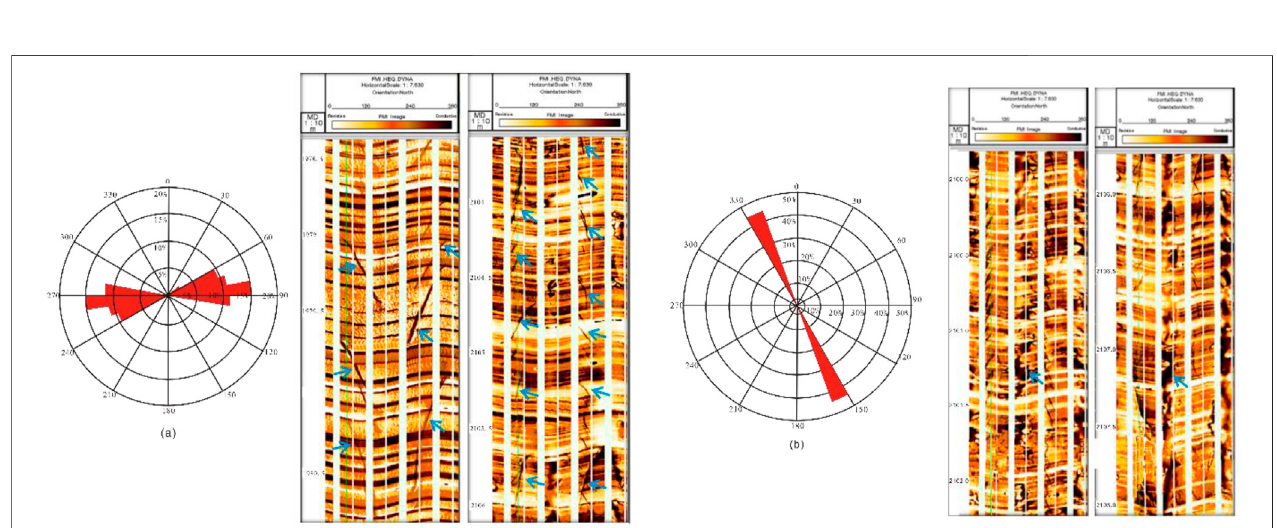
FIGURE 11 | Drilling induced fractures trend NEE-SWW (A) and sidewall cavings trend NNW-SSE (B) .